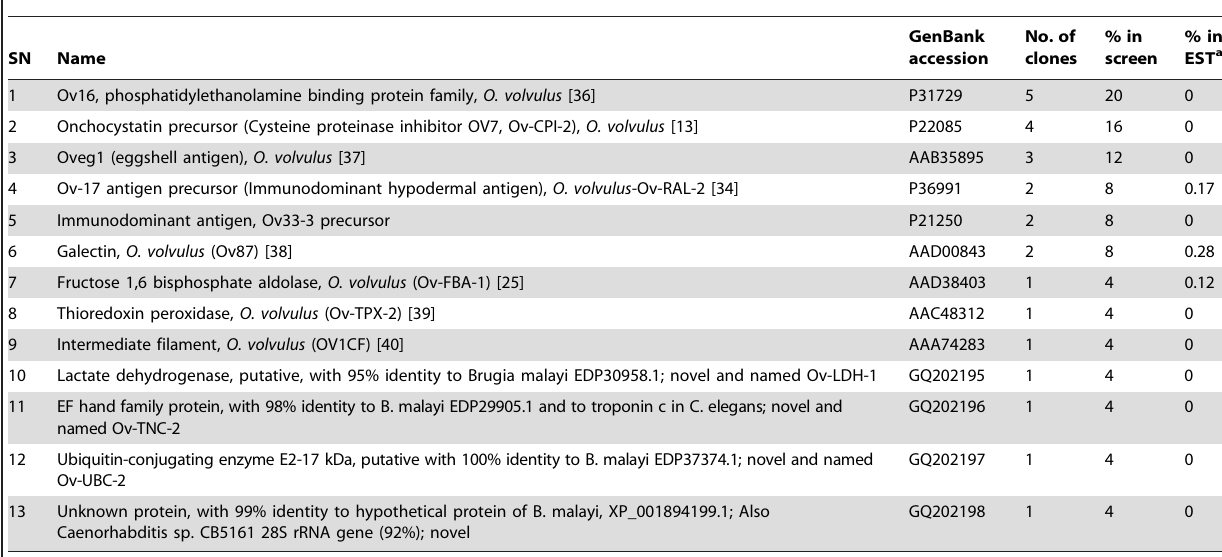
Table 2. cDNA clones isolated from the mL3 cDNA